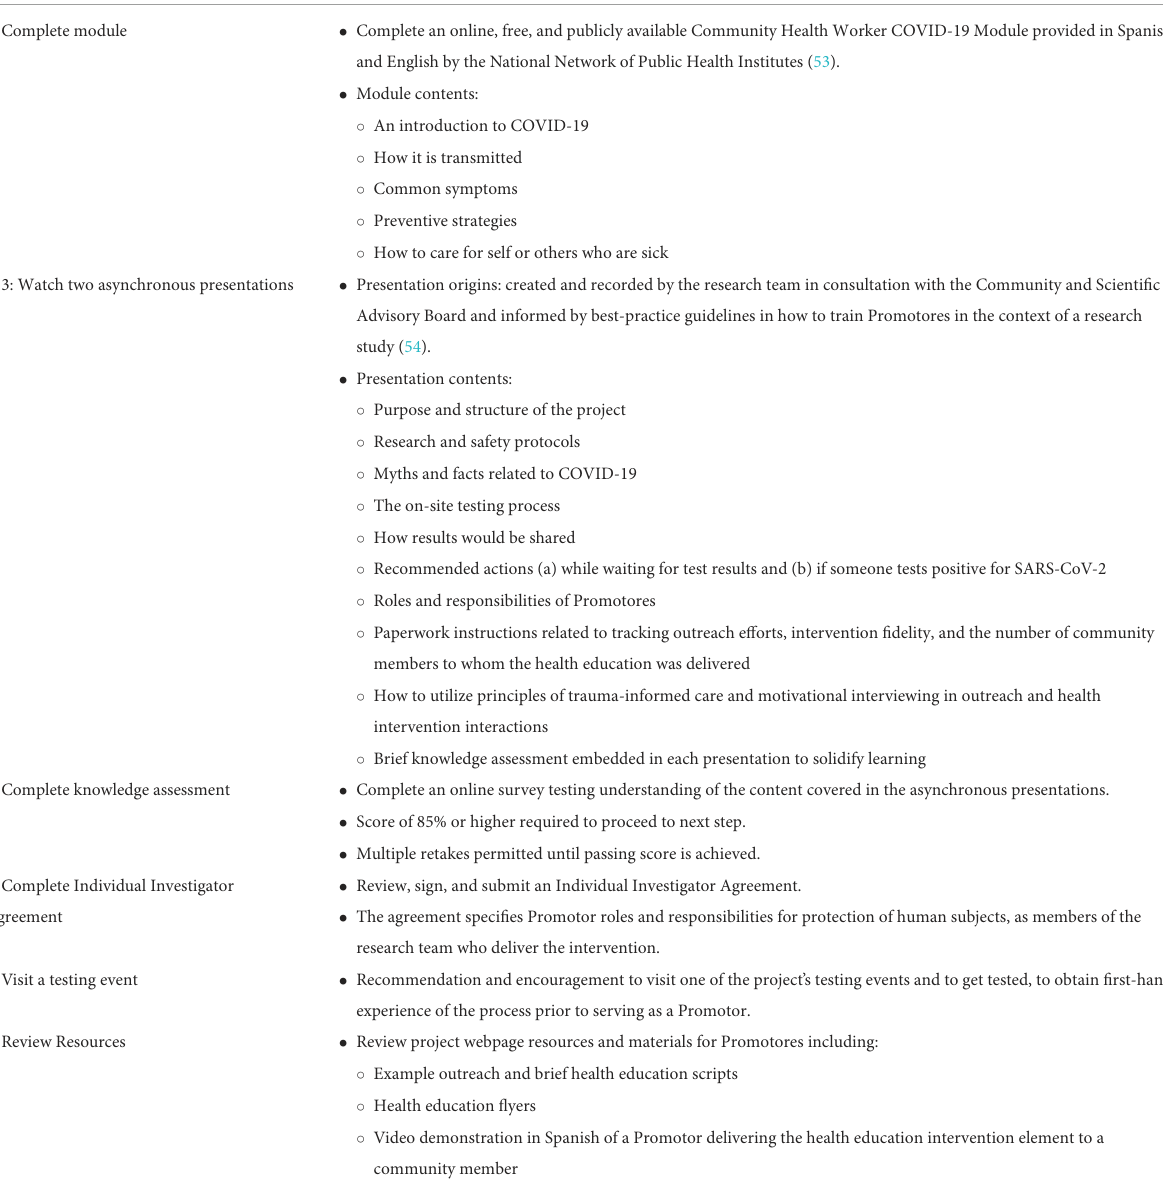
TABLE 3 Promotor training